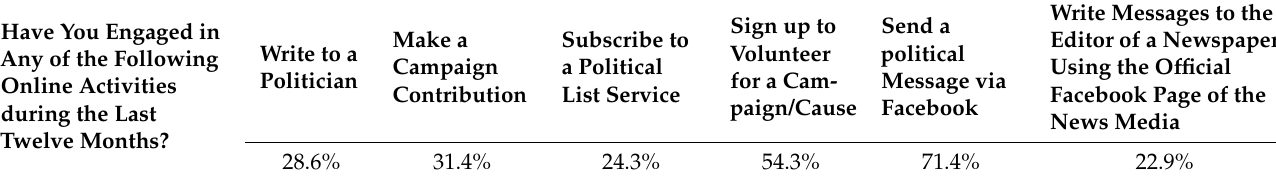
Although a high percentage of participants were interested in politics, as Table 2 shows the vast majority of users did not belong to a political party ( n = 75%). Table 2. Do you belong to a political party? Do You Belong to a Political Party? Yes ( n = 25%) No ( n = 75%) There seemed to be much more active participation in online rather than offline en- gagement in civic activities (see Table 3). In the last twelve months, most of the participants had sent a political message via Facebook ( n = 71.4%), and most had signed up as vol- unteers for a campaign or a political cause ( n = 54.3%). Minorities of the sample had contributed to a campaign ( n = 31.4%), written to a politician ( n = 28.6%), subscribed to a political list service ( n = 24.3%) or written messages to the editor of a newspaper using the official Facebook page of the newspaper ( n = 22.9%). This finding demonstrates that the participants are actively engaging in political activities within the social media. Table 3. Have you engaged in any of the following online activities during the last twelve months? Have You Engaged in Any of the Following Online Activities during the Last Twelve Months?